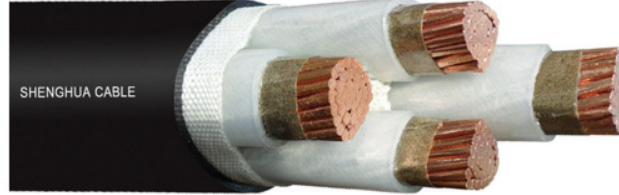
Figure 13. XPLE insulated power Figure 13 . XPLE insulated power cable.